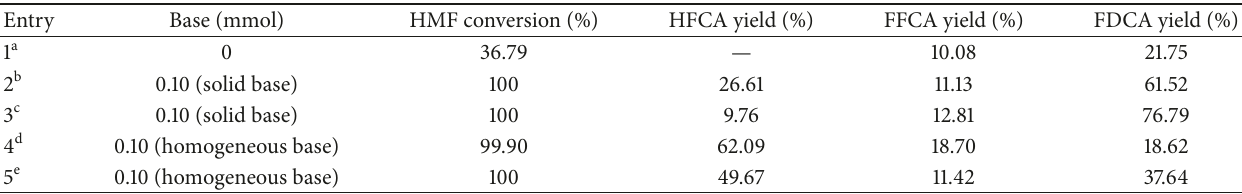
Table 3: The effect of base on the HMF oxidation.